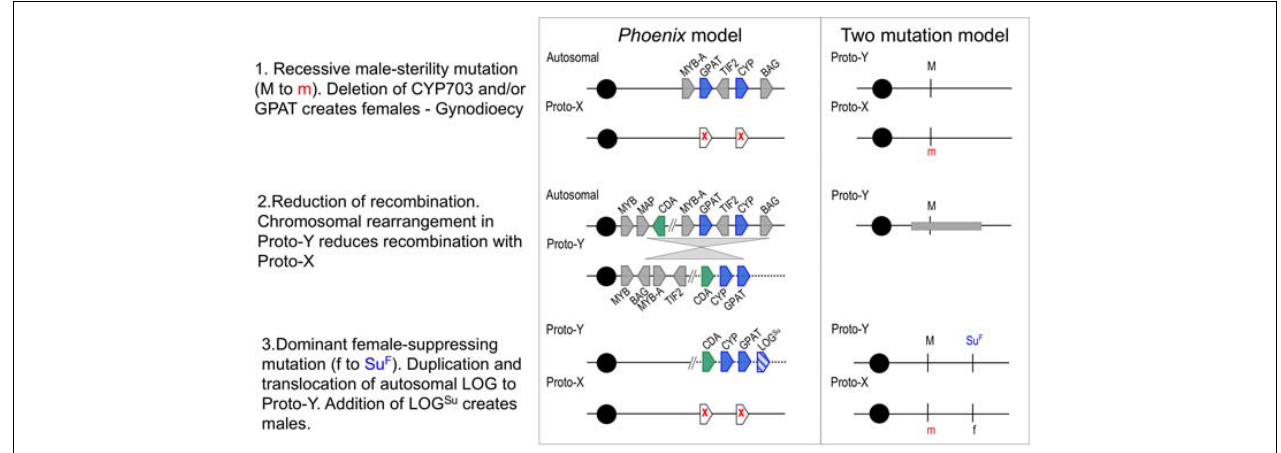
FIGURE 1 | A proposed step-wise model of evolution in the Phoenix (including Date Palm) sex-determination region compared with the two-gene model for sex determination (adapted from Charlesworth et al., 2005). Two genes are deleted from Proto-X (white pentagons with red x), a later rearrangement (gray triangles) relocates multiple genes and a final duplication and translocation of a gene (pentagon with blue lines) with potential female-suppressing characteristics (LOG Su ) creates males and females. Gene abbreviations and gene IDs MYB: LOC105059740, MAP: LOC105059742, CDA: LOC105059743, MYB-A: LOC105059783, GPAT (GPAT3): LOC105059961, TIF2: LOC105059784, CYP (CYP703): LOC105059962, BAG: LOC105059785. Cytidine deaminase (CDA) was the only gene with male-conserved kmers present in both male and female